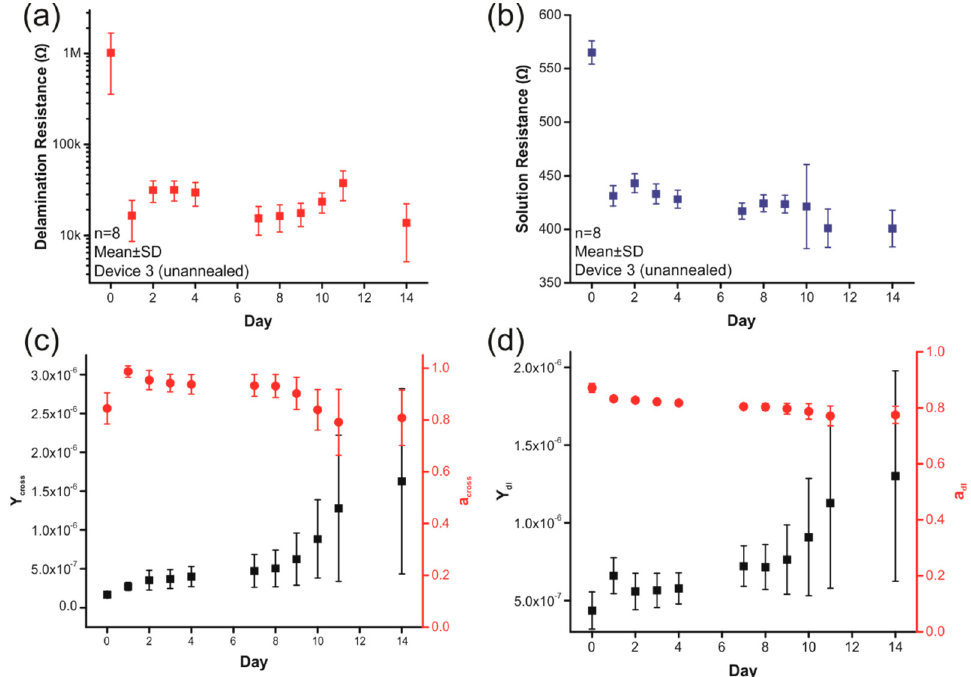
Figure 8. The results of modeling electrochemical impedance spectroscopy (EIS) spectra between a thin-film platinum electrode insulated between 10 μ m Parylene layers and a large platinum counter electrode during a 14-day soak in 1× phosphate buffered saline (PBS) at 37 °C. Both ( a ) R S and ( b ) R delam drop after the first day, while the magnitudes of both ( c ) the cross-insulation capacitance ( Y cross ) and ( d ) the double layer capacitance ( Y dl ) steadily increase over the course of the test.